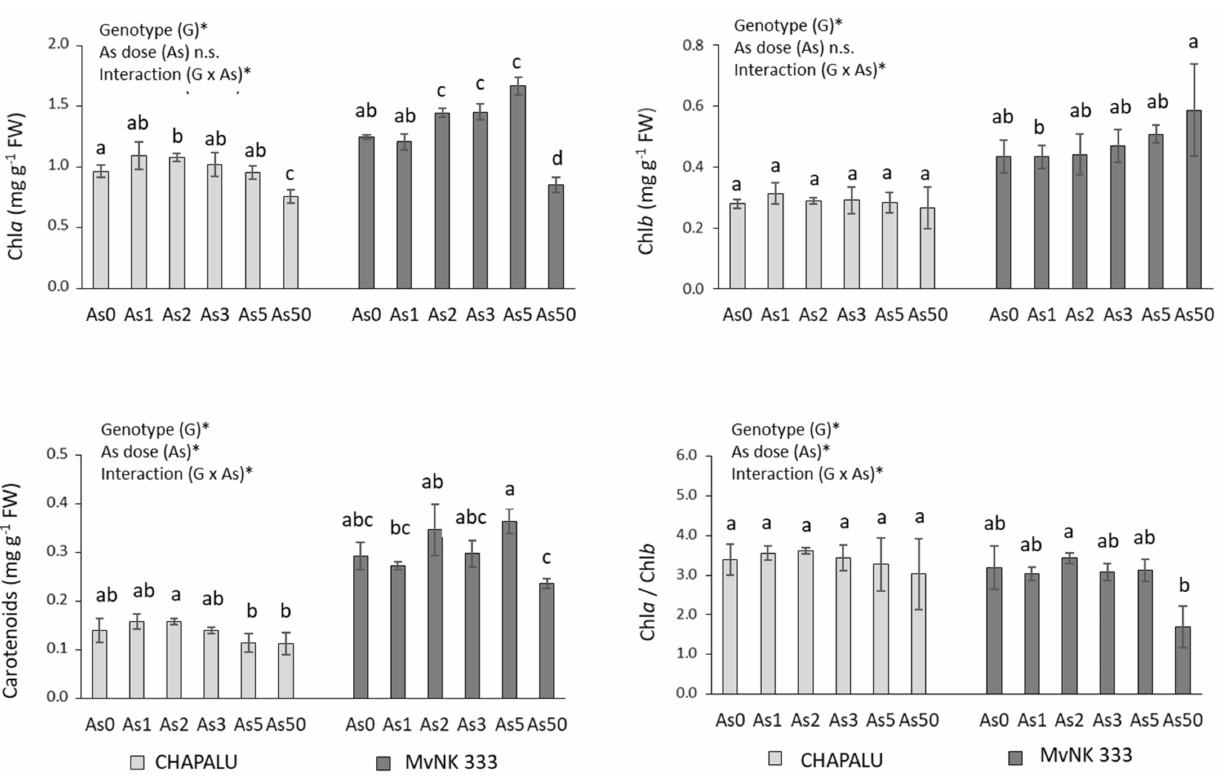
Figure 2. Effect of arsenic on photosynthetic parameters of two cultivars of maize and their statistical evaluation. Data are presented as means ± SD from three biological replicates (n = 6). As0, As1, As2, As3, As5 and As50—arsenic addition to soil in mg kg − 1 . The differences between variants of the experiment were determined using the Kruskal–Wallis test followed by Dunn’s post hoc test for multiple comparisons. Different letters on the top of bars indicate a significant difference ( p < 0.05) between variants of the experiment for each cultivar. Data were also examined using two- way ANOVA with the factors As dose (As), genotype (G), and interaction (G x As). *—significance at 0.05 level; n.s.—not significant.